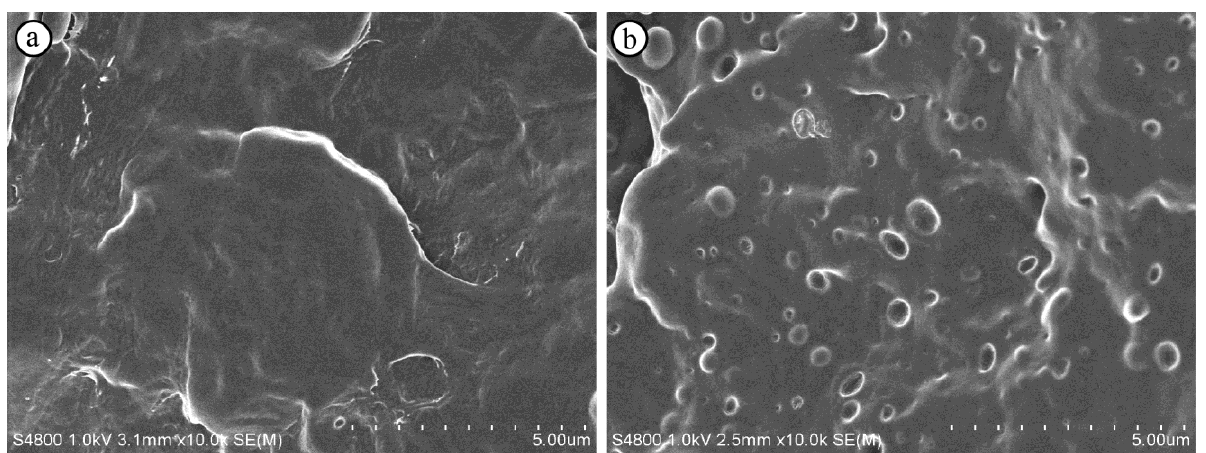
Figure 6. Scanning electron micrographs of the fractural surfaces after the impact tests of ( a ) the neat PP and ( b ) PP/EBC blend